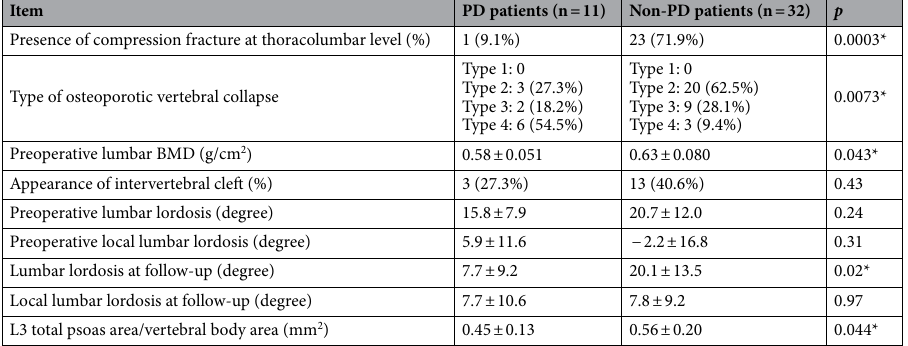
Table 3. Differences in imaging findings in patients with and without Parkinson’s disease. PD Parkinson disease, BMD Bone mineral density. * p < 0.05.